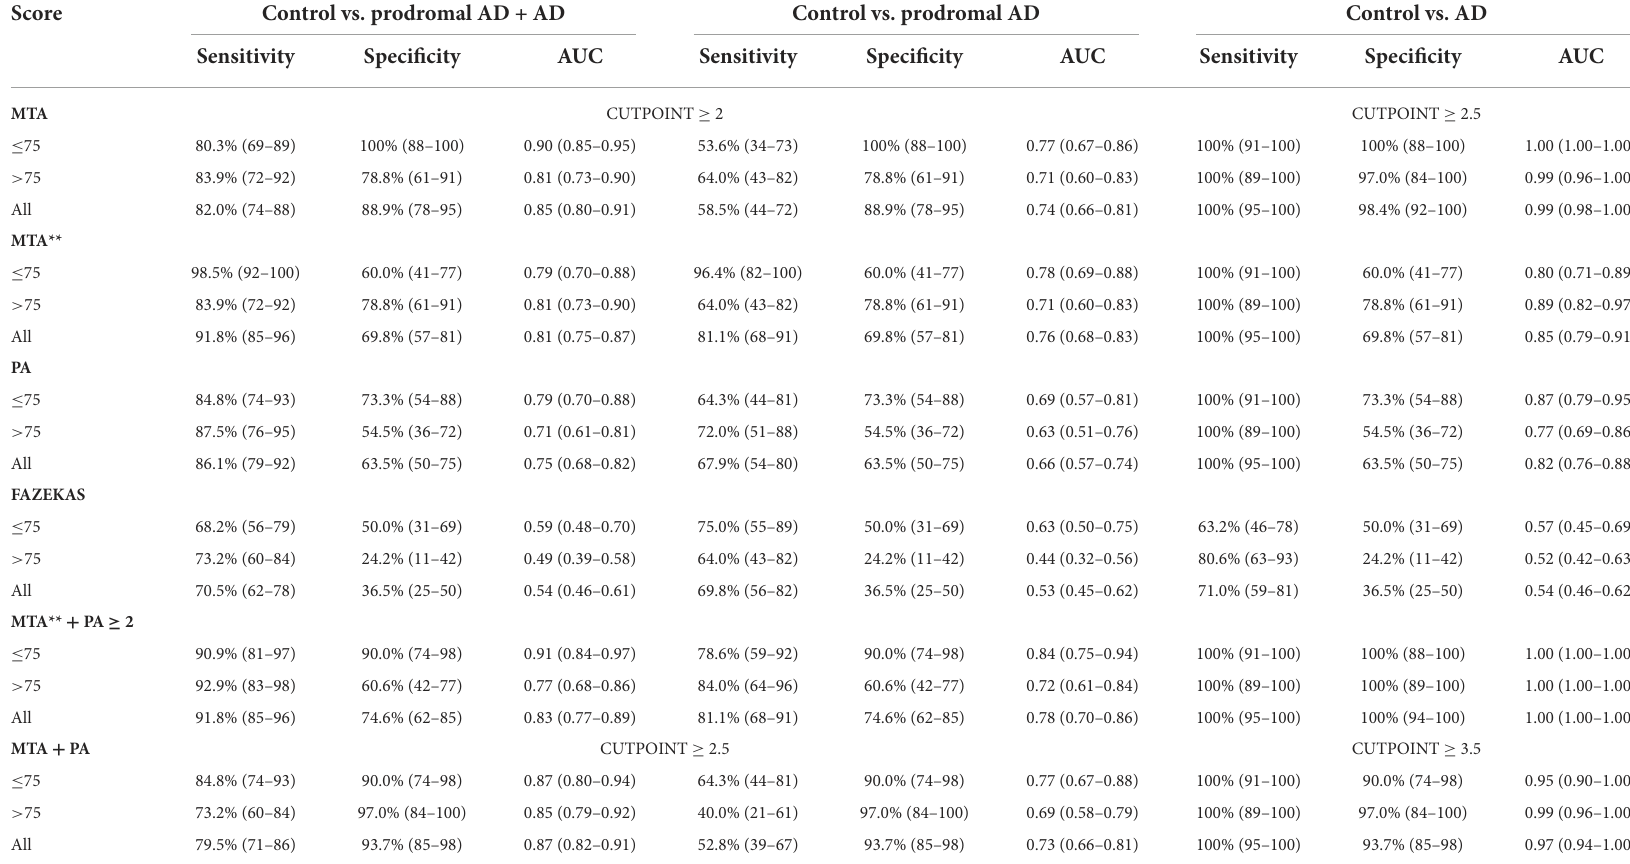
TABLE 2 Sensitivity, specificity, and AUC for different imaging scoring methods for diagnosis of prodromal AD or AD, or AD dementia